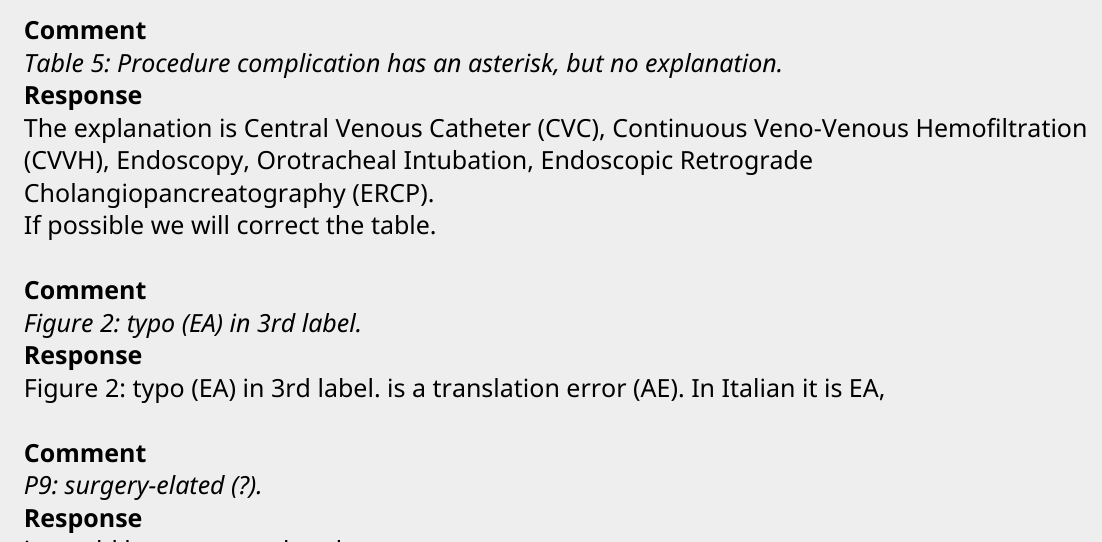
Table 5: Procedure complication has an asterisk, but no explanation.